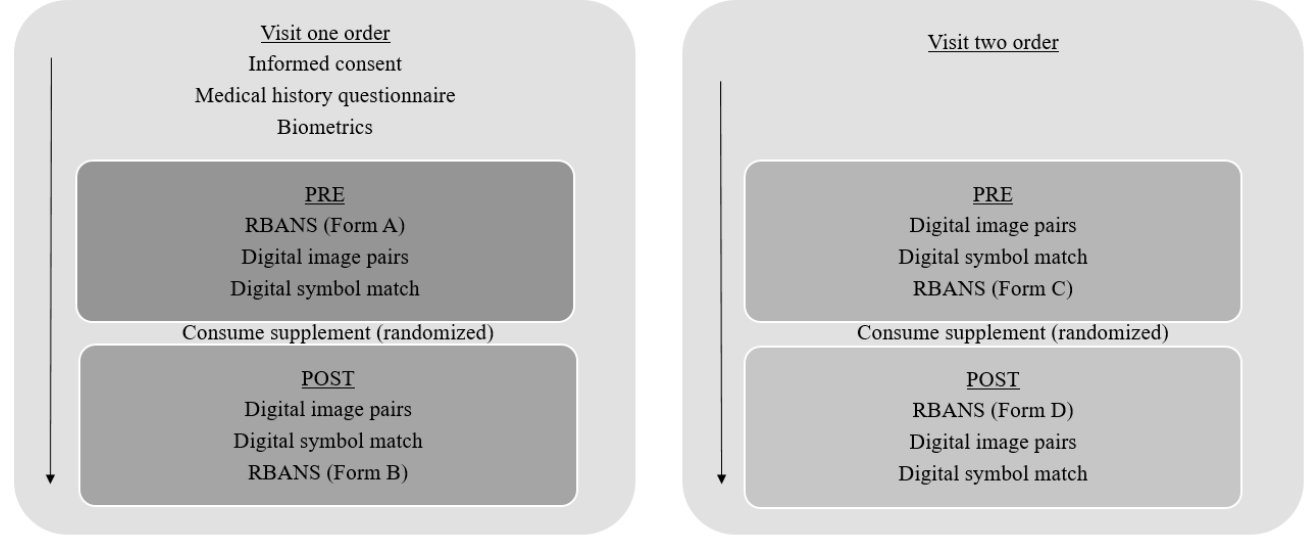
Figure 1. Trial order.